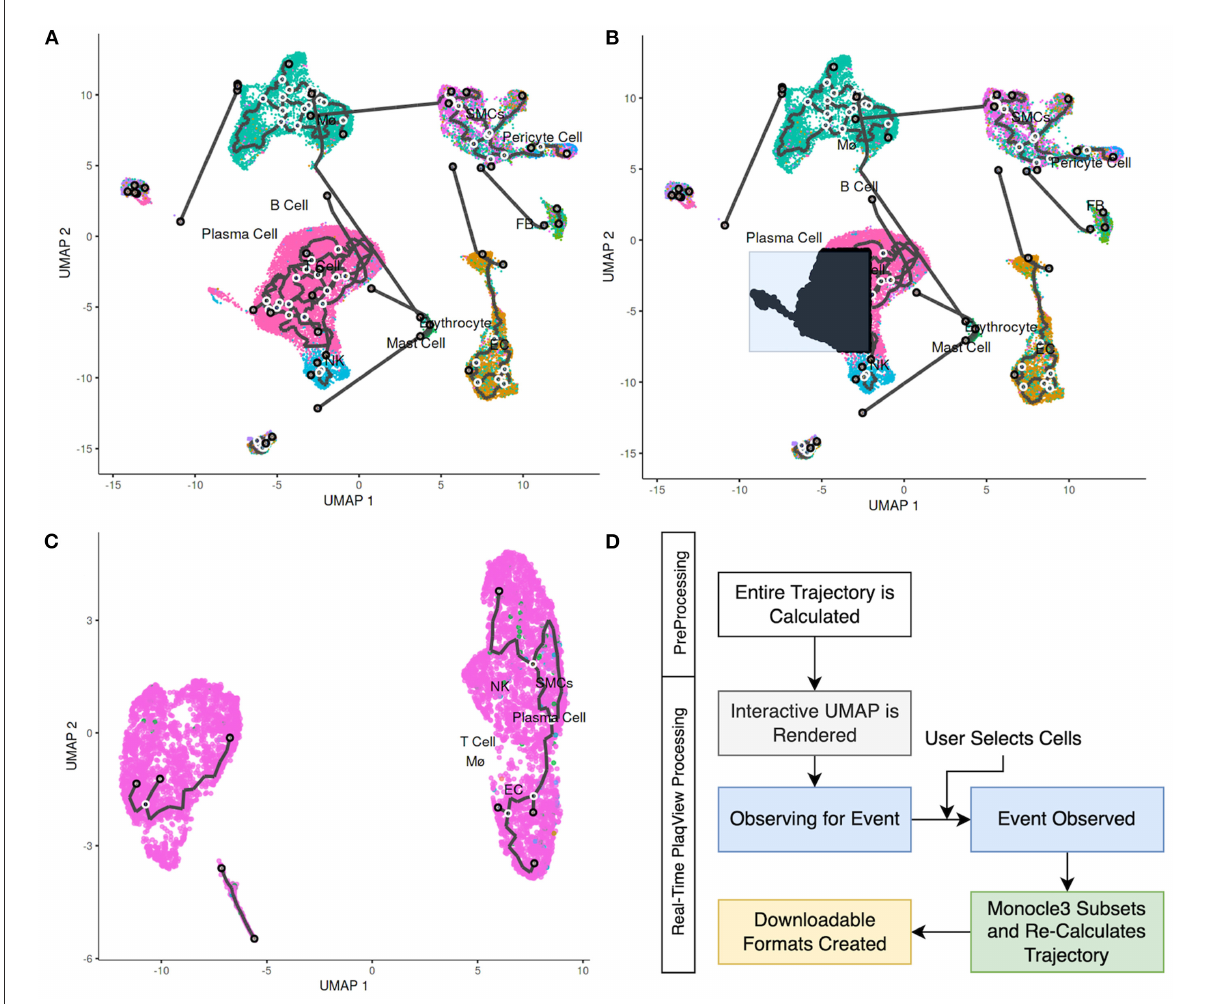
FIGURE7 PlaqView 2.0 enables interactive RNA trajectory inference. (A) Full cell trajectory inferences are presented to the user, as demonstrated using the Alsaigh et al. dataset. (B) Selected cells are highlighted in black. These cells can be subsetted and their (C) trajectories can be re-calculated in PlaqView as powered by Monocle 3. (D) We pre-compute the overall trajectory during the pre-processing stage, and recalculations of subset trajectories are done ad hoc as needed by PlaqView as an on-demand